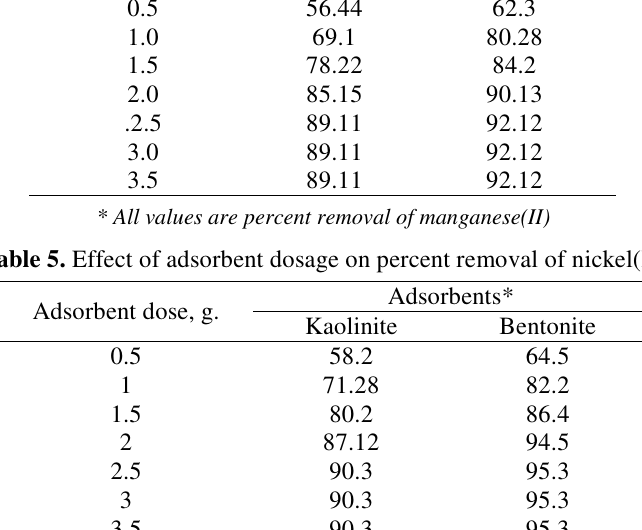
Table 4. Effect of adsorbent dosage on percent removal of manganese(II) Adsorbents * Adsorbent dose, g.